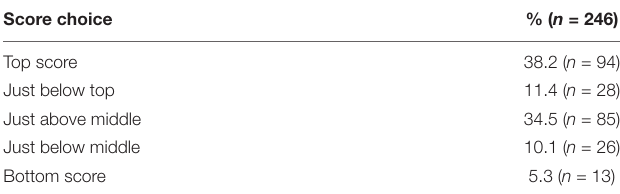
TABLE 3 | Modified rank order paradigm: information children select to compare.